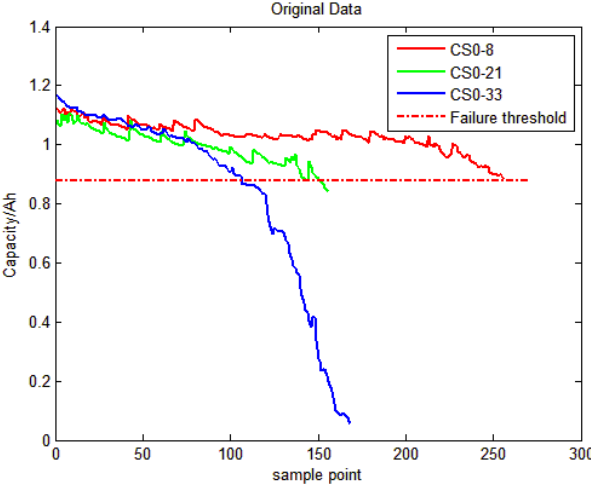
Figure 3. The measured capacity of raw data.